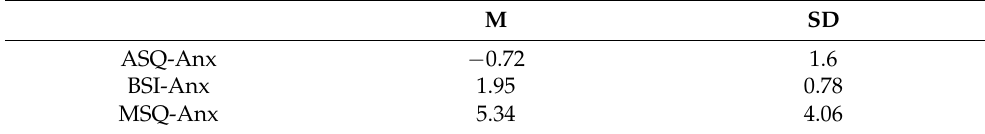
Table 3. Correlations between the main variables of the study. Table 2. Mean and SDs of the study variables.